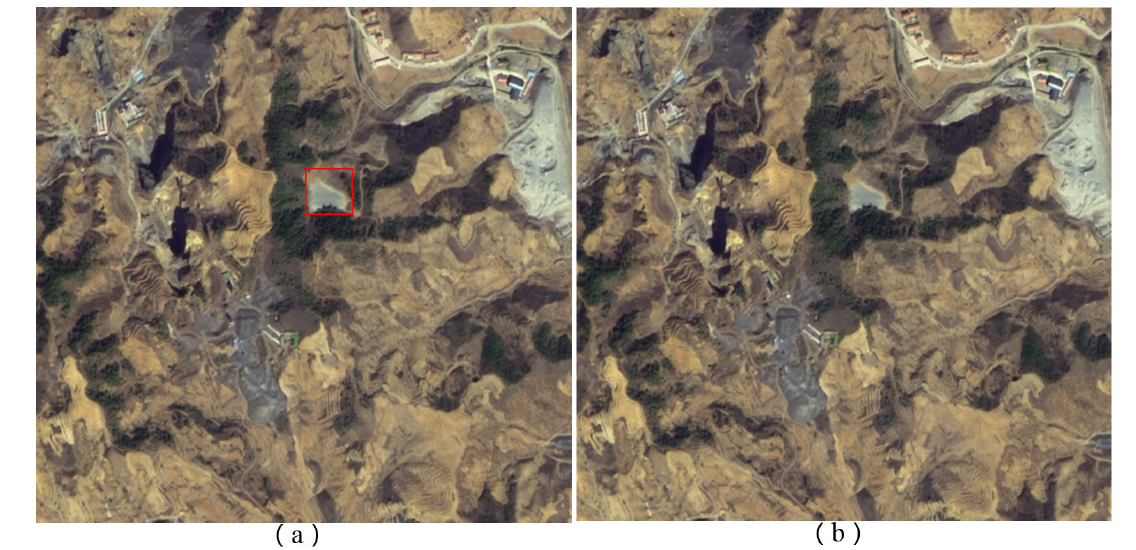
Figure 13 . Small tailings pond target missed detection. ( a ) the red bounding box represents the GT of the small tailings pond and ( b ) the prediction results of all models.